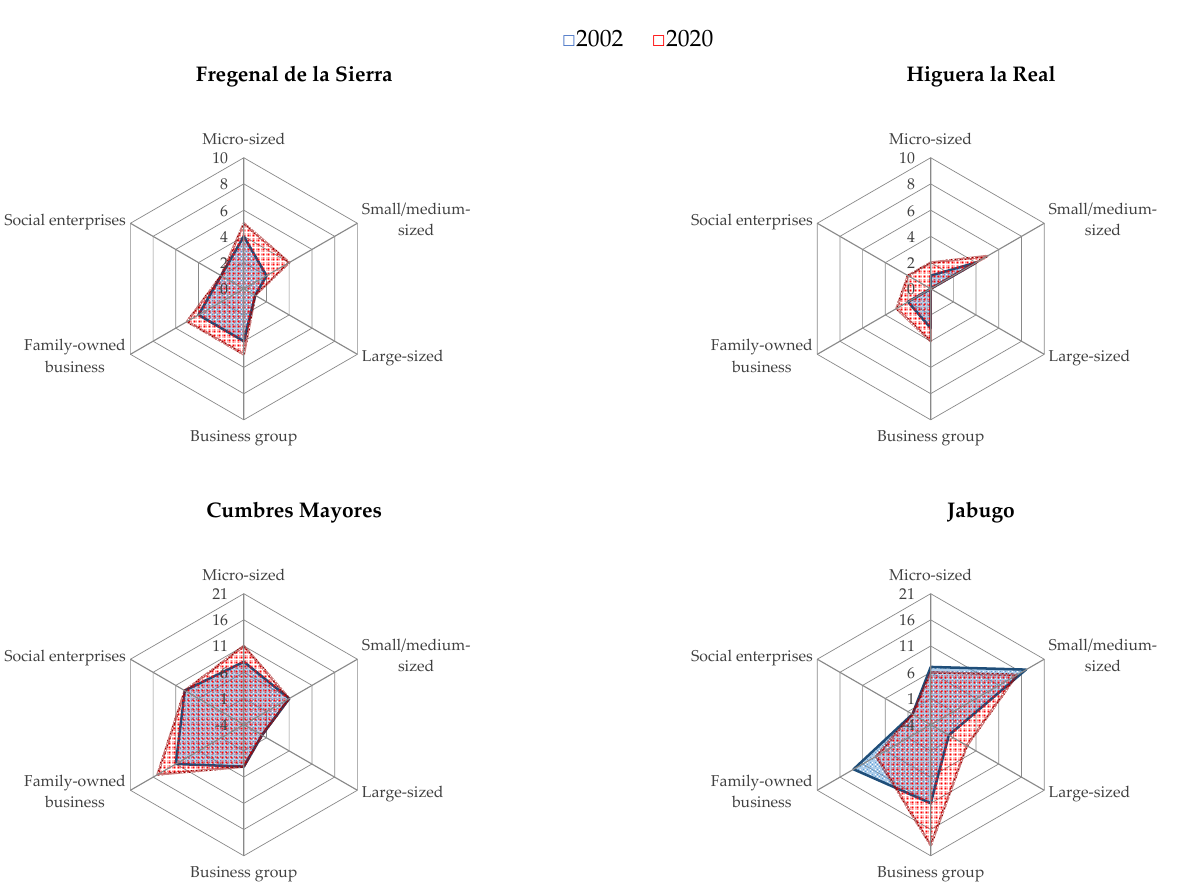
Figure 15. Changes in the size and type of companies (2002 and 2020). Source: Q1 [81,95]. Authors own elaboration.